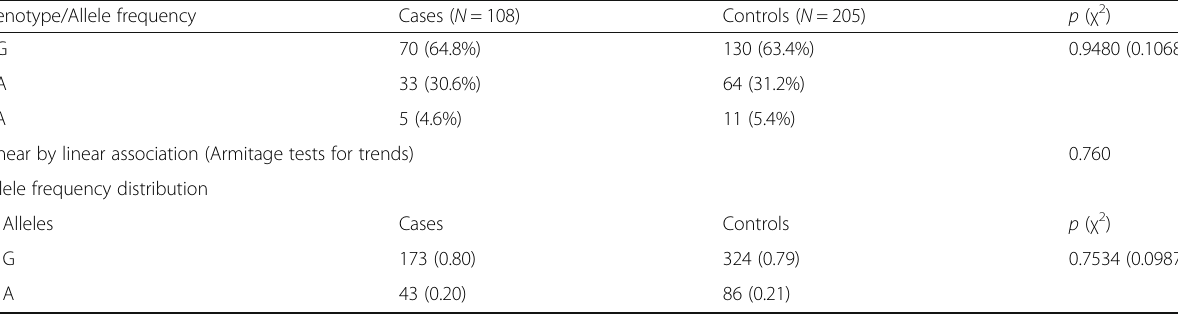
The table represents the genotypic frequency and the allelic frequency for different models. ( N